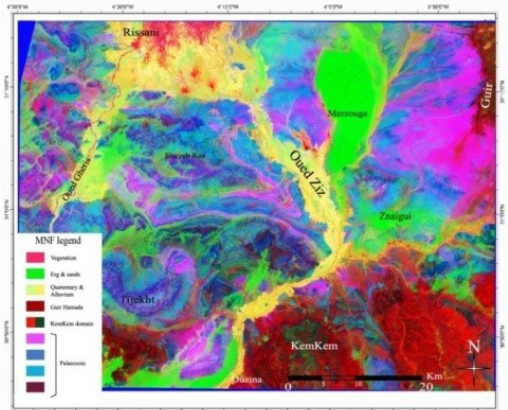
Figure 9: MNF RGB image, with (Red=EV1, Green=EV2, Blue=EV3).